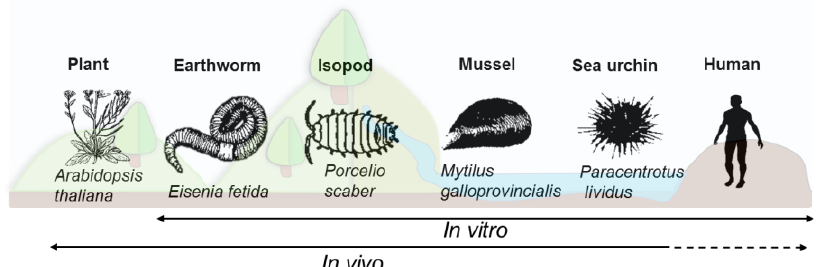
Figure 2. The different models discussed in the current review, and their main experimental usage in the laboratory: in vivo (whole organism experiments) and in vitro (isolated cells or cell lines).